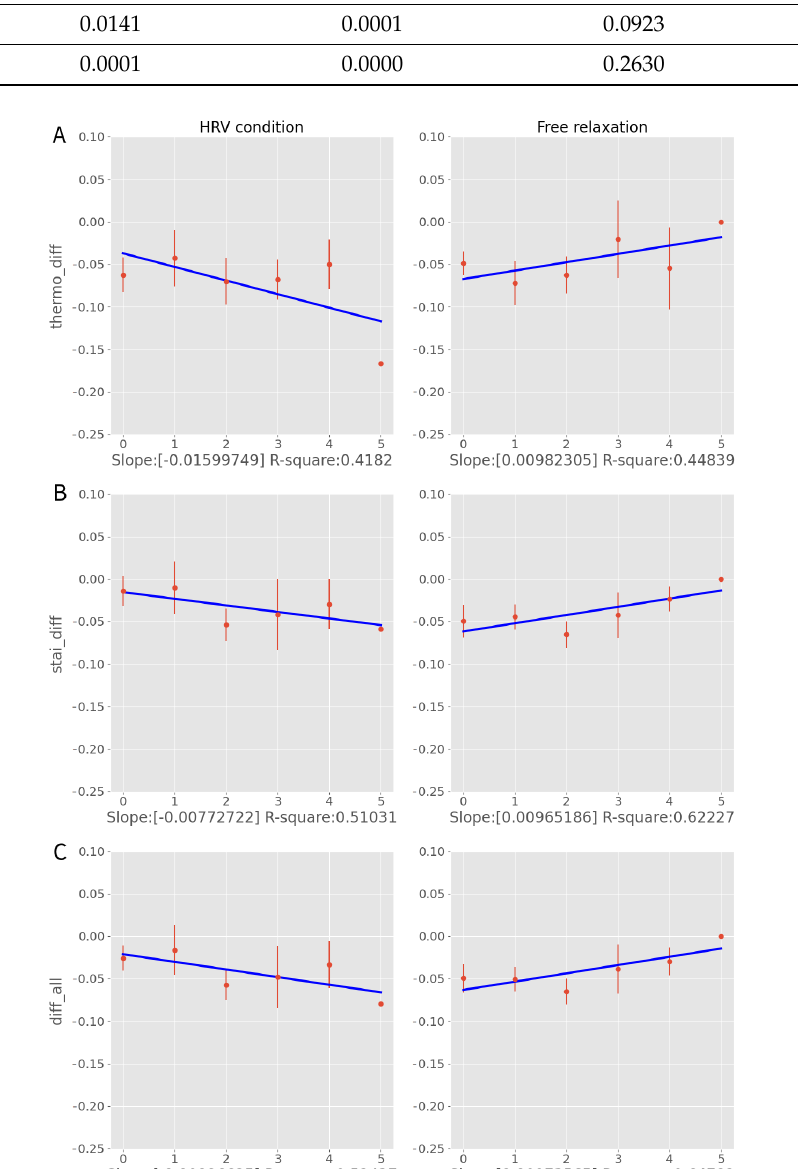
Figure 2. Linear regression fitted to variables. Each point is the average of the variables for each group. Each group was formed according to the number of times a given relaxation was performed. Subfigure ( A ) shows the comparison on thermo_diff, i.e., the relative difference in the Distress Thermometer (DT), ( B ) the comparison on stai_diff, the relative difference in the mean of the STAIS-5 discrate scale and ( C ) the comparison on diff_all, which describes the relative difference in the mean of the STAIS-5 scale and the Distress Thermometer